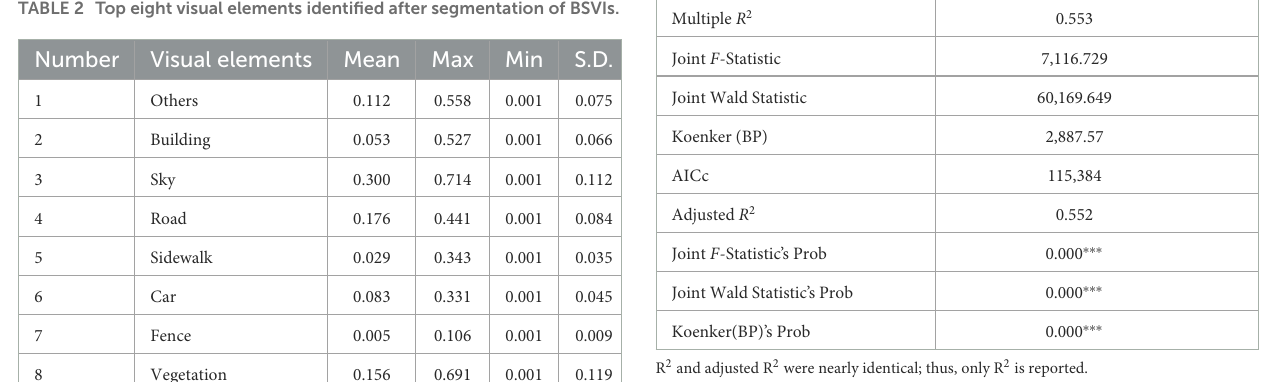
TABLE 2 Top eight visual elements identified after segmentation of BSVIs.